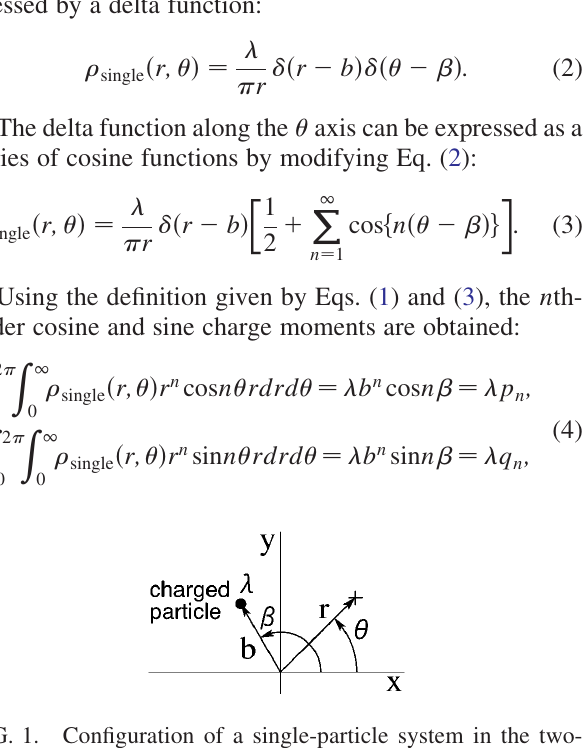
FIG. 1. Configuration of a single-particle system in the two- dimensional transverse